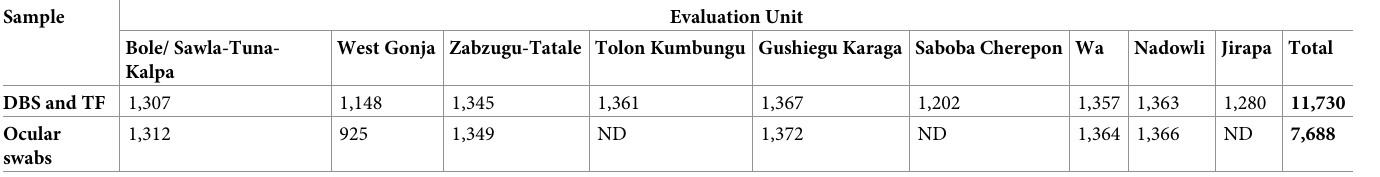
Table 1. Number of samples analysed by evaluation